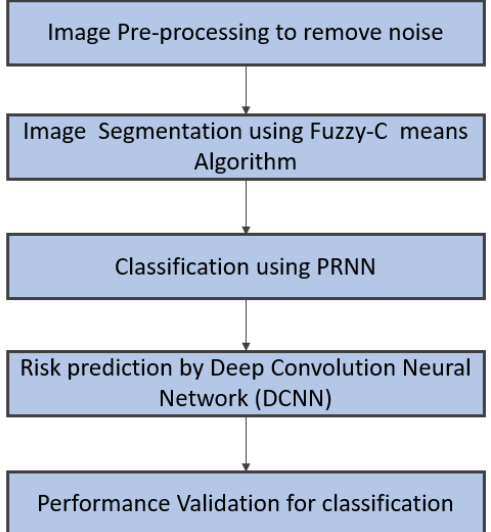
Figure 2. Overall workflow of proposed